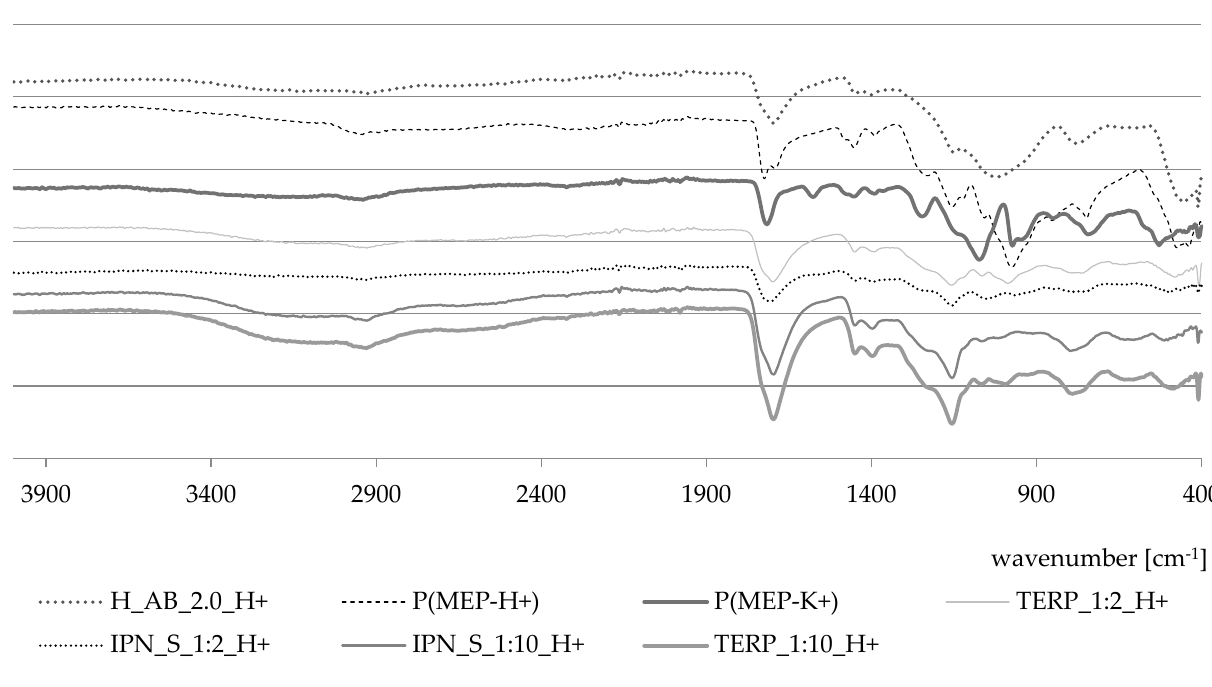
Figure 9. FTIR spectra of the first component network in two ionic forms, the second component network, IPNs and their corresponding